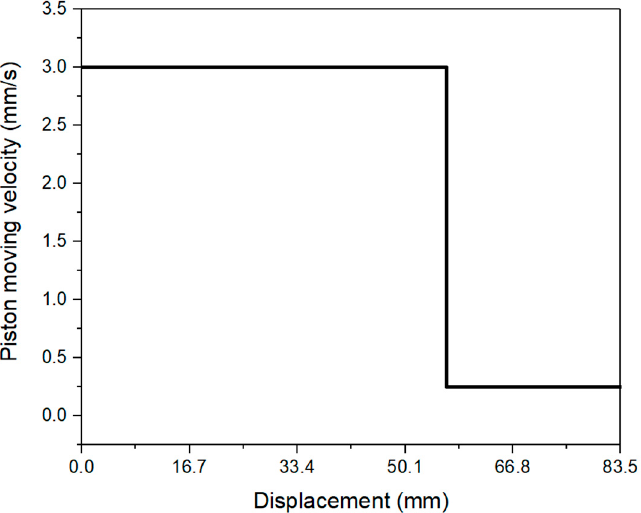
Figure 4. Predefined piston speeds and displacements for the test of extrusion pressure with di ff erent ages.